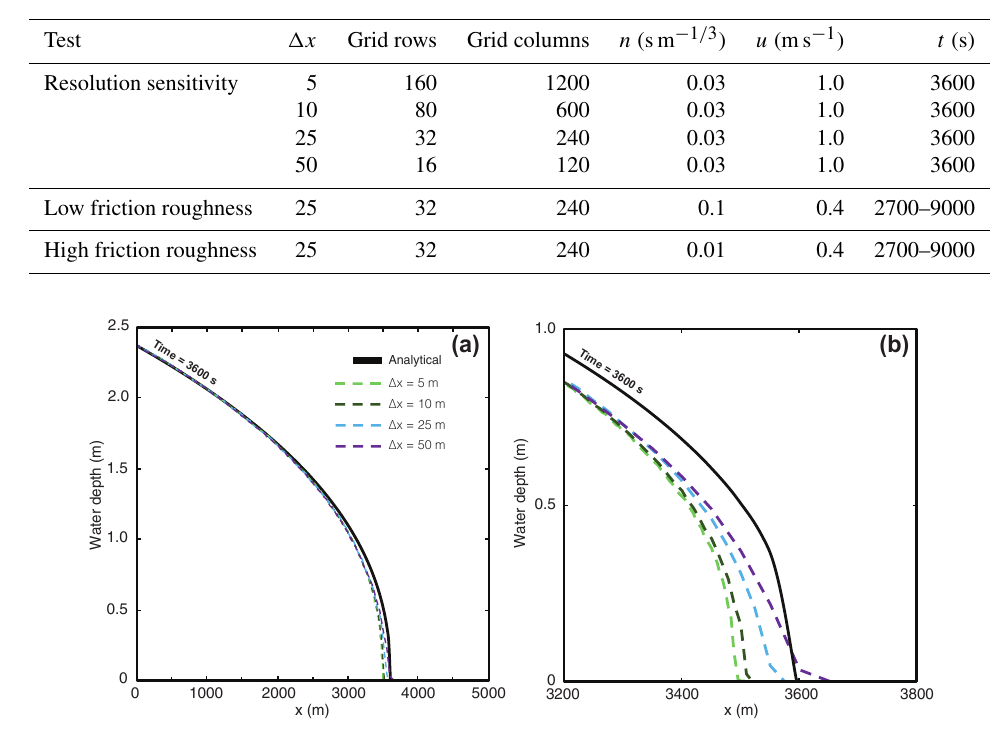
Table 3. Grid characteristics and parameters for analytical solution tests.